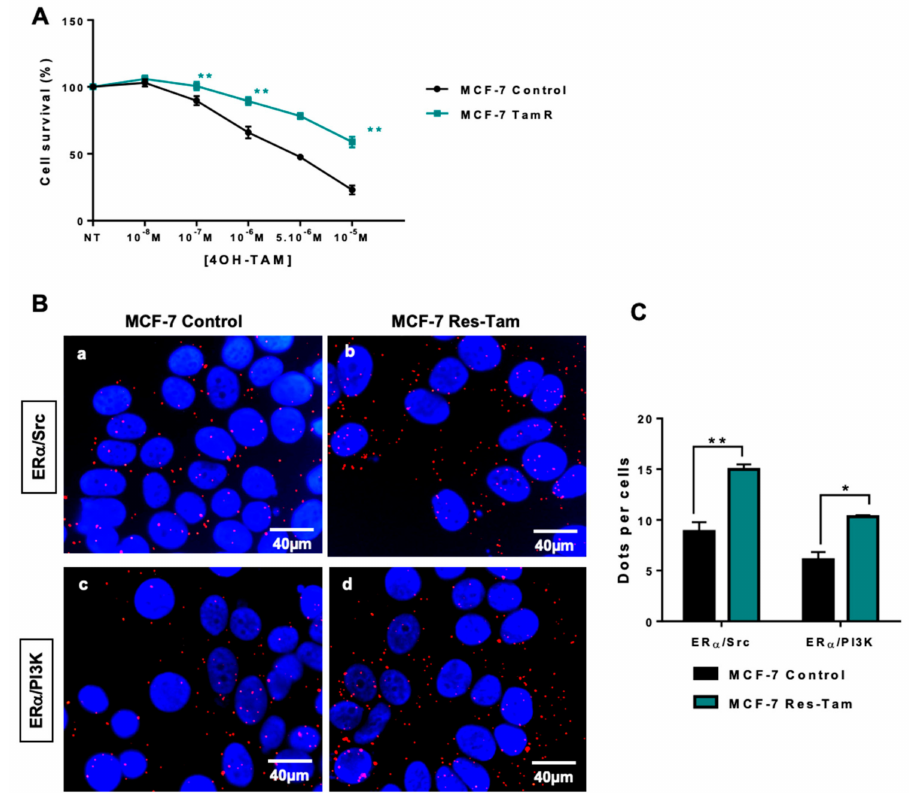
Figure 3. ER α / SrcandER α / PI3Kinteractionsintamoxifen-resistantMCF-7cells. ( A